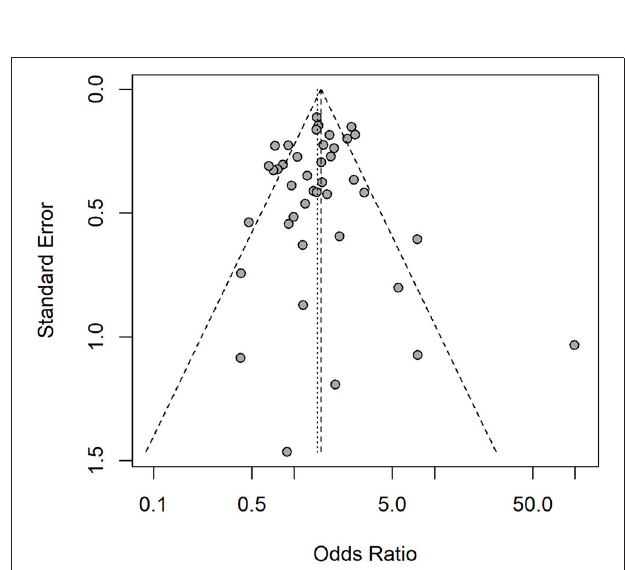
FIGURE 9 | Funnel graphic utilized for assessment of publication bias, which has assessed the contact of dogs and cats and frequency of anti- Toxocara spp. antibodies in under-18 and adults, according to selected articles used in the meta-analysis from 2009 to 2021.